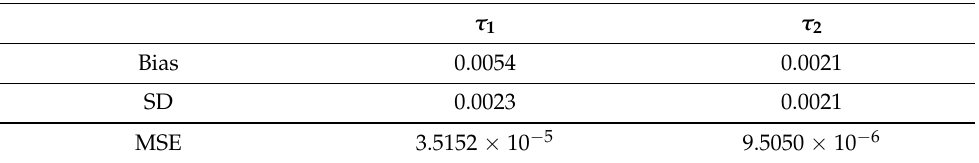
Table 10. Bias, SD and MSE evolutions with respect to the parameter τ variation for PLGSIMF with the logit link function and n = 1000.